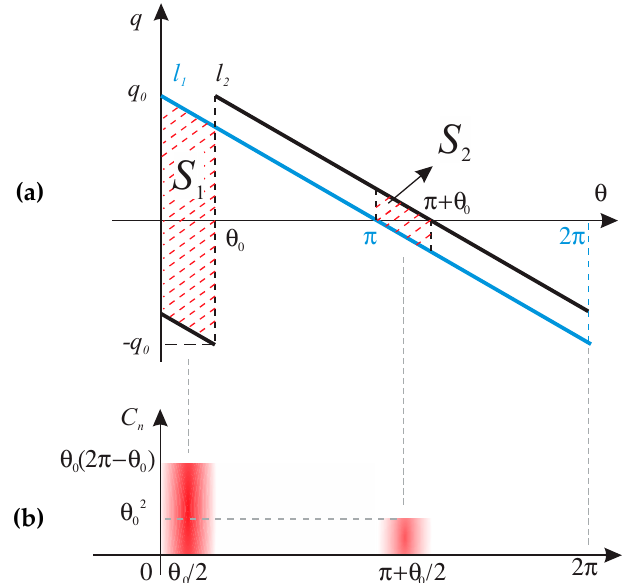
Figure 8. ( a ) Conceptual charge distribution on the two stacked SRRs (l 1 ,l 2 ), ( b ) normalized capacitance C n (or E-field concentration) on SRR based on charge distribution.